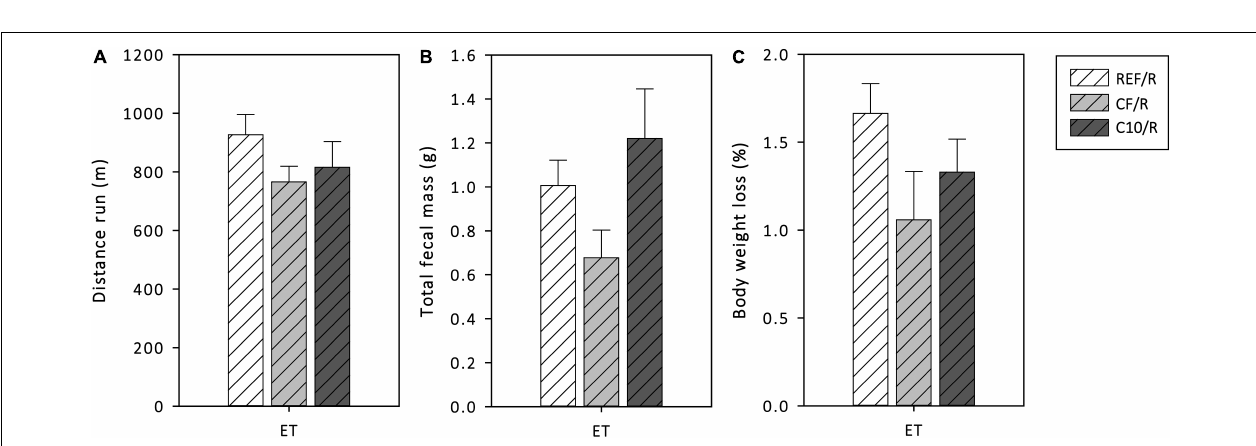
FIGURE 2 | Distance run (A) , total fecal mass defecated (B) and body weight loss (C) during the final exhaustion test (ET). REF, reference diet; CF, 5% cocoa fiber-enriched diet; C10, 10% cocoa-enriched diet; R, runner groups. Data are expressed as mean ± SEM ( n = 8).